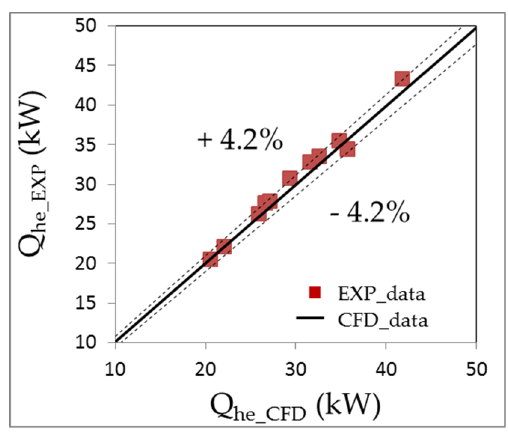
Figure 13. Heat transfer rate ( Q he ) of the experimental results against the CFD results for all cases.